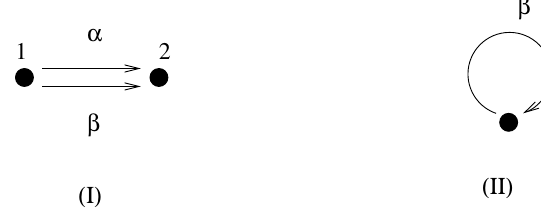
Figure 1. Two examples of quivers with nodes and edges